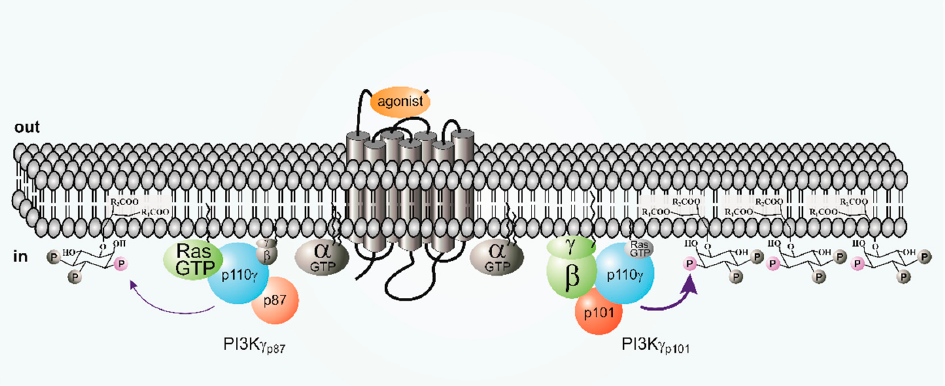
Figure 3. Schematic Regulation of class I PI3Ks. Class IB PI3K γ p87 and PI3K γ p101 are differentially regulated by Ras and by GPCRs via the interaction with G βγ . Active Ras is indispensable for the translocation of cytosolic PI3K γ p87 to the plasma membrane. In contrast, interaction with G βγ is sufficient for PI3K γ p101 membrane translocation. Both G βγ and Ras contribute to the stimulation of the lipid kinase activity of membrane-associated PI3K γ enzymes.